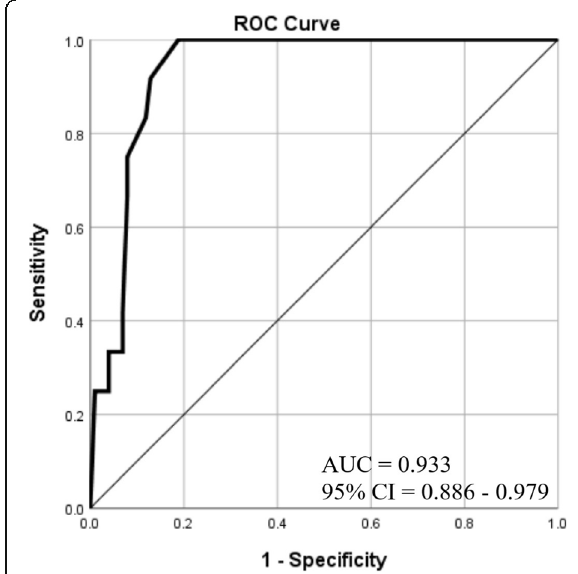
Fig. 4 ROC curve of total XRS to predict intensive care